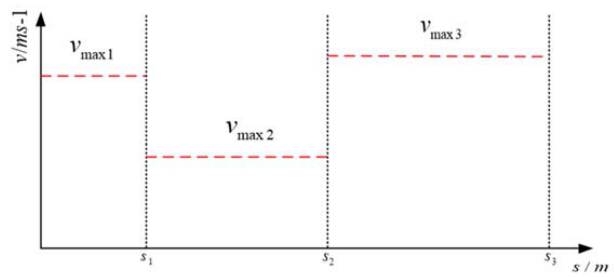
Figure 5. Speed Limit along the Desired Path.